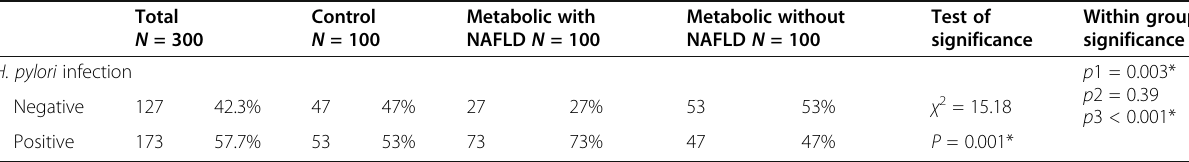
Table 4 H. pylori stool Ag results in the studied groups